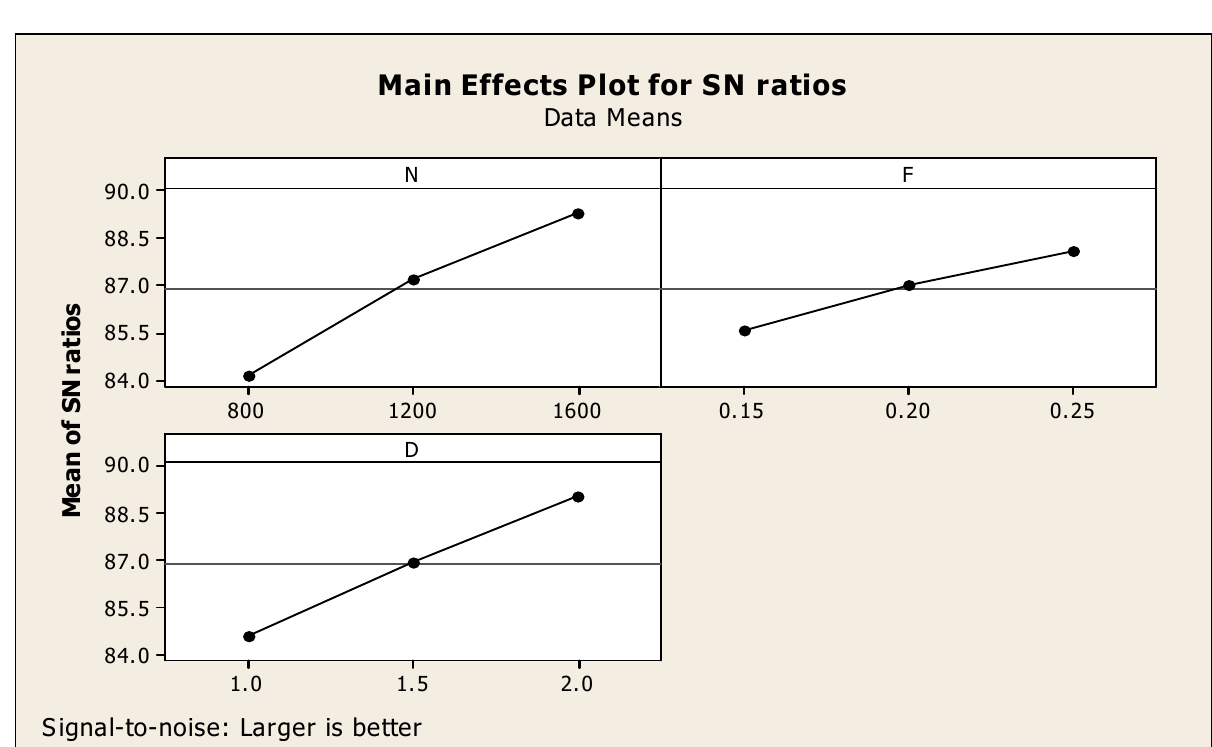
Figure 5. MRR-related major effects diagram with respect to signal to noise ratios.